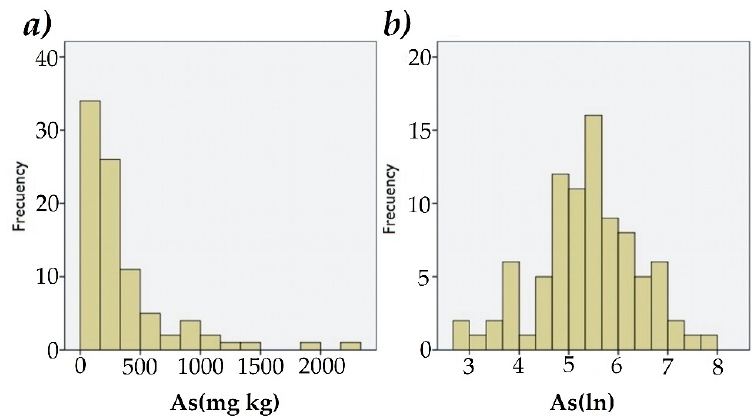
Figure 3. Frequency of As concentration: no logarithmic transformation ( a ), with logarithmic transformation ( b ). As = arsenic, As(ln) = arsenic values logarithmically transformed.